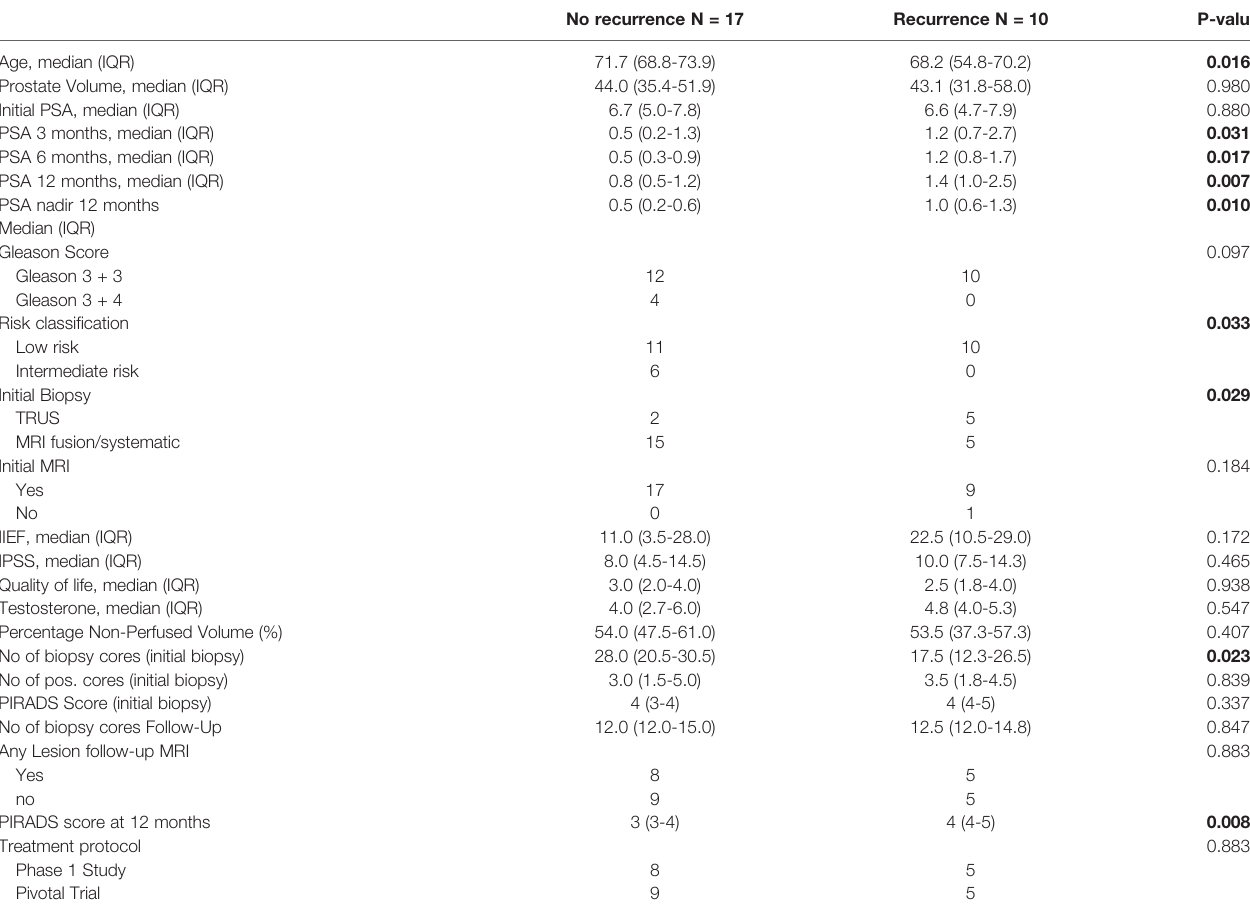
TABLE 3 | Comparison of patients with and without cancer